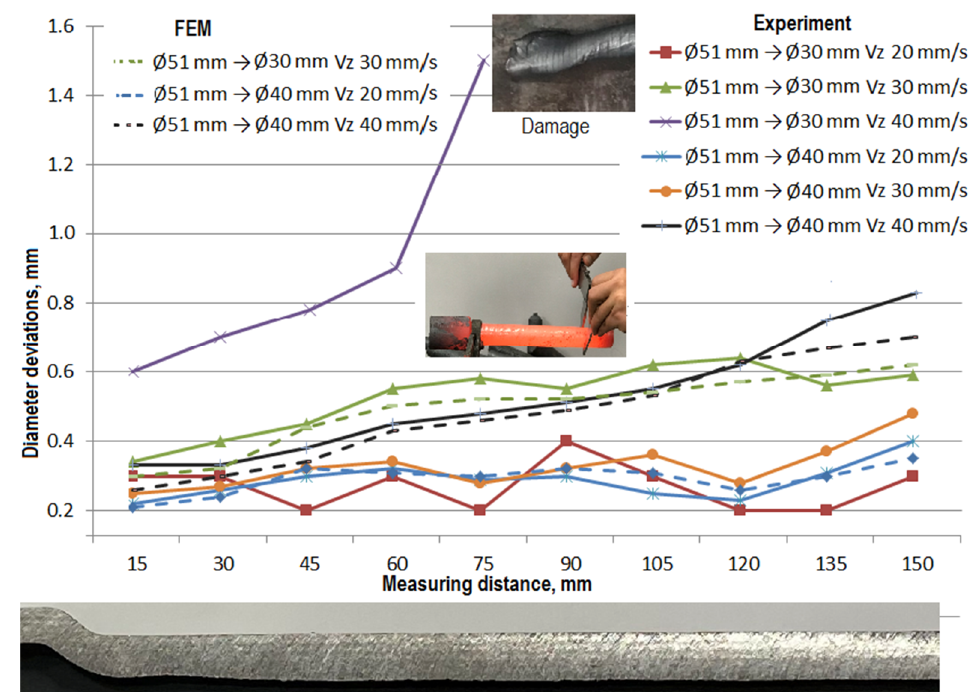
Figure 7. Changes of hollow part reduced diameter deviations and wall thickness distributions depending on presented skew rolling process parameters.